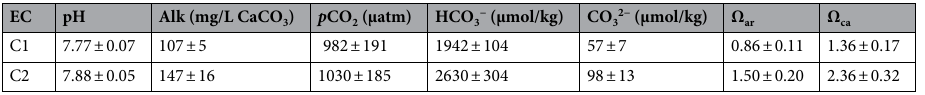
Table 2. CO 2 -carbonate system factors for two experimental conditions (EC) in the pre-conditioning of the Pacific oyster C. gigas . C1 recirculating aquaculture system (RAS) without calcium reactor (control), C2 RAS with the calcium reactor, pH, Alk alkalinity, pCO 2 partial pressure of carbon dioxide, HCO 3 − bicarbonate, CO 32 − carbonate, Ω ar saturation state of aragonite, Ω ca saturation state of calcite.